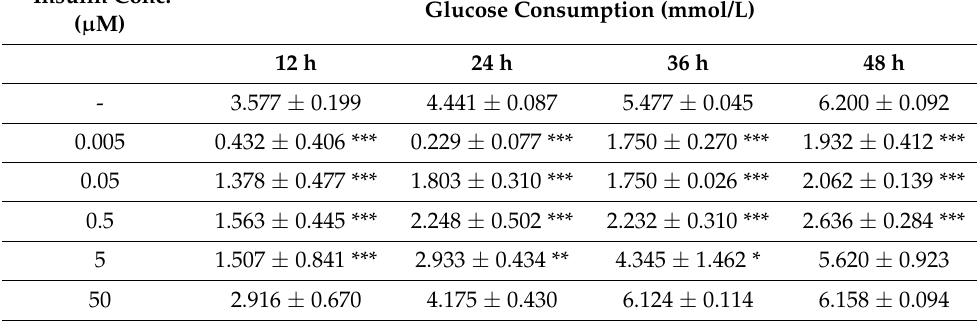
Table 1. Effect of different concentrations of insulin on glucose consumption in HepG2 cells at different time intervals to conduct IRM.